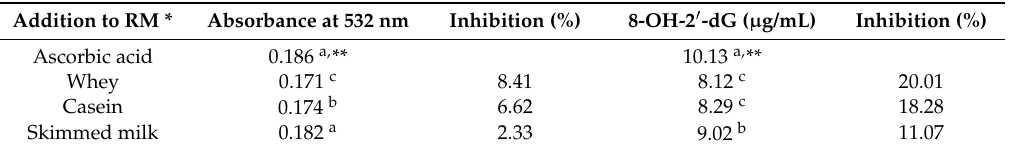
Table 2. Effect of bovine colostrums protein on the DNA damage induced by bleomycin-Fe 3+ /Asc and oxidation of 2 ′ -dG to 8-OH-2 ′ -dGinduced by Fe 2+ -EDTA/H 2 O 2 /Asc. Addition to RM *